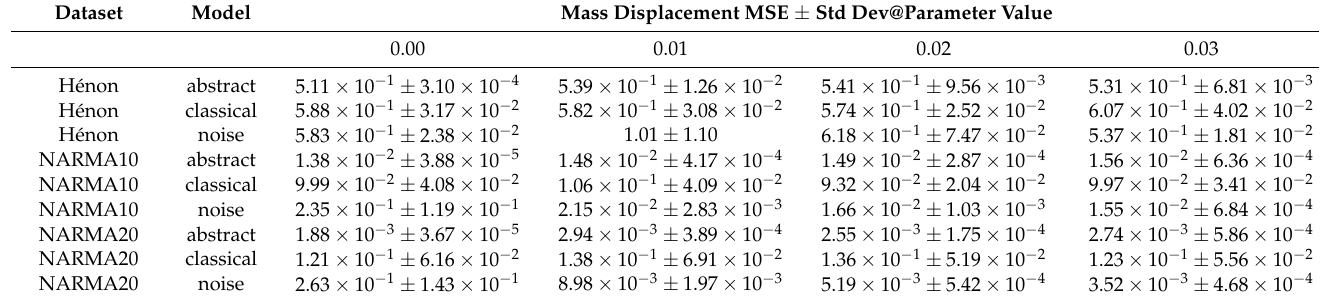
Table A4. Average MSE for the experiments simulating tolerances in mass placements over 10 experiment runs. The parameter gives the amplitude of the noise added to the initial mass